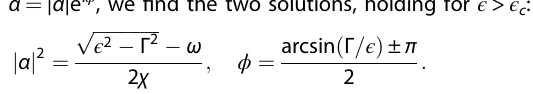
Fig. 2 Metrological performance of the critical parametric quantum sensor. ( a ) QFI for the estimation of ω as a function of ϵ , computed for ω / Γ = 1 and various values of χ / Γ . In the Gaussian case ( χ → 0), the QFI diverges at ϵ ¼ In the inset, we show that S ω ¼ max ϵ S Hom ω (cid:8) c ð Γ χ Þ (cid:4) 1 , with c ≃ 0.55. Since N ¼ Θ ð for χ / Γ ≲ 10 − 2 . ( b ) SNR for the homodyne ( S Hom ω ) and heterodyne detection ( S Het ω ) at ω / Γ = 1 and χ / Γ = 0.04. Homodyne detection virtually saturates the